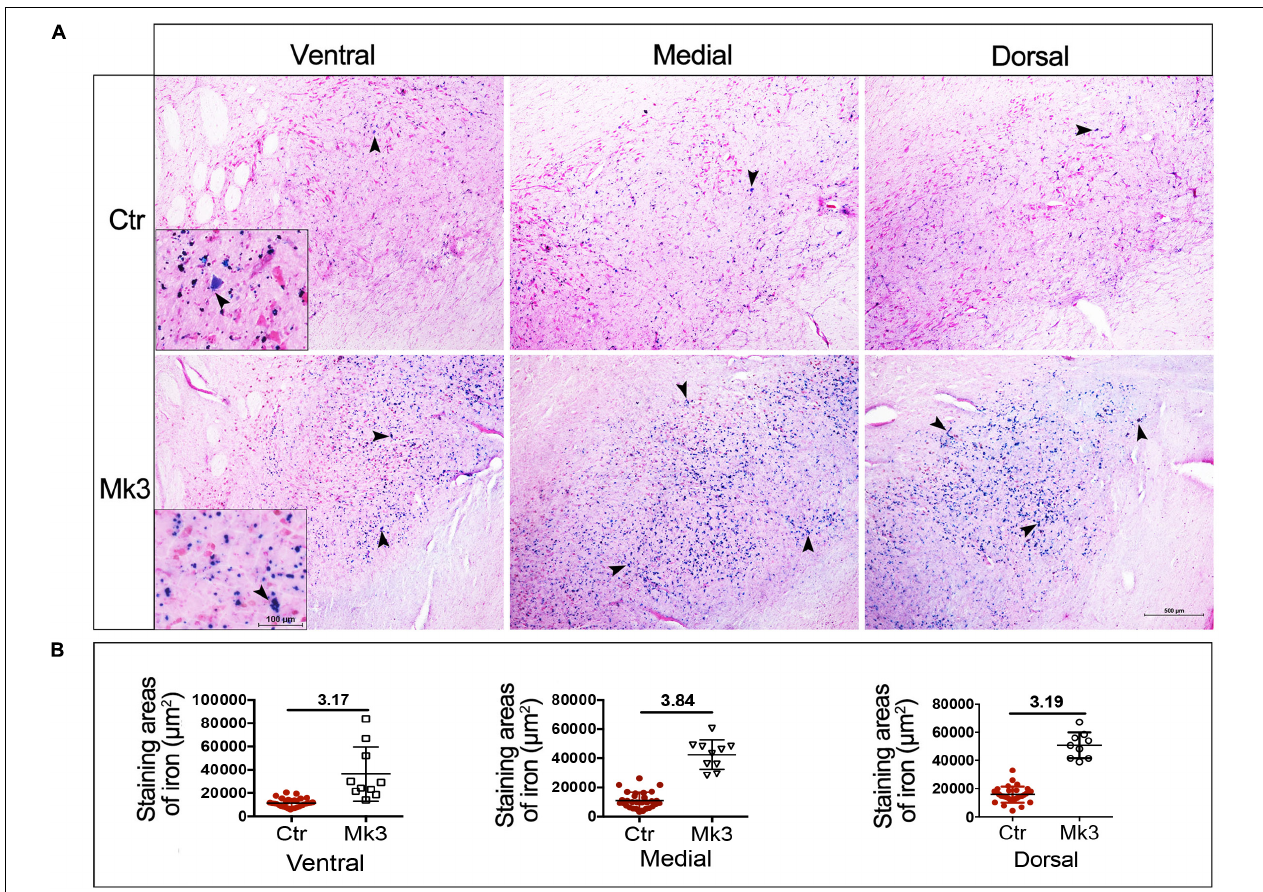
FIGURE 5 | Iron accumulation in the SN in MPTP-lesioned Mk3 monkeys. (A) The microphotograph of Perls’ Prussian blue staining (denoting iron) in control and in monkey 3 (Mk3) that was subjected to MPTP injection and displayed the most severe structural and functional deficits among MPTP-lesioned monkeys. Note the obvious increase of blue staining in the SN of Mk3, which can be observed in ventral, medial and dorsal aspects of the SN. The insets (ventral) reveal that the accumulated iron is mainly deposited extracellularly, with relatively little deposition in neuronal somas. (B) Quantitative comparison of the area of Perls’ Prussian blue staining in the SN between control monkeys and Mk3. It shows that the areas of staining were obviously elevated in ventral, medial, and dorsal aspects of SN in Mk3 when compared to that of